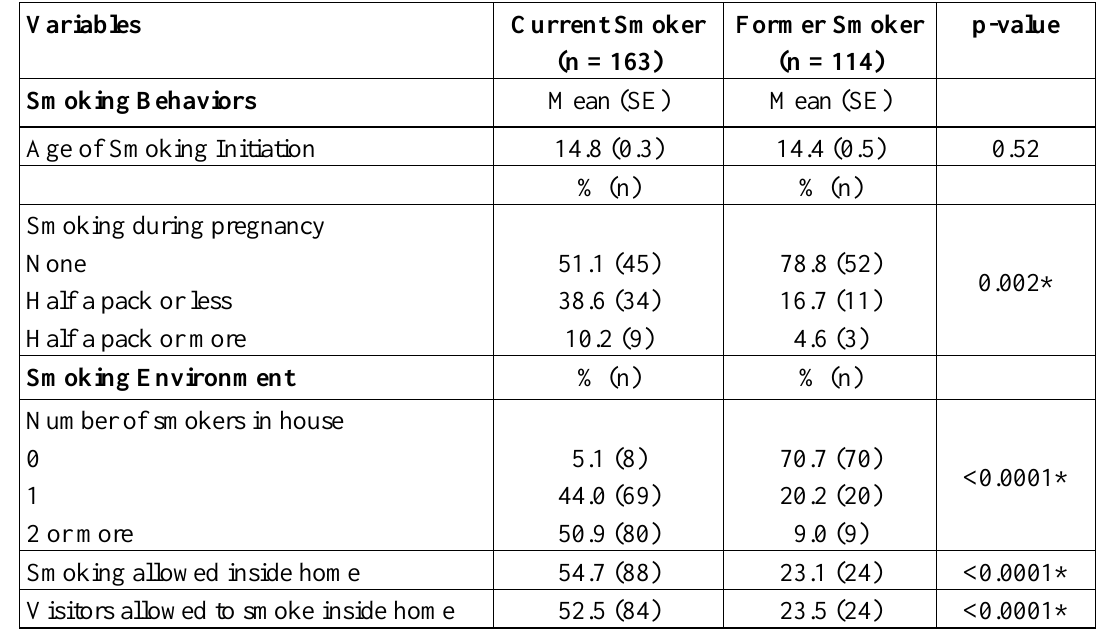
Table 2. Differences in Smoking Behaviors of Current and Former Smokers among American Indian Adults. n =